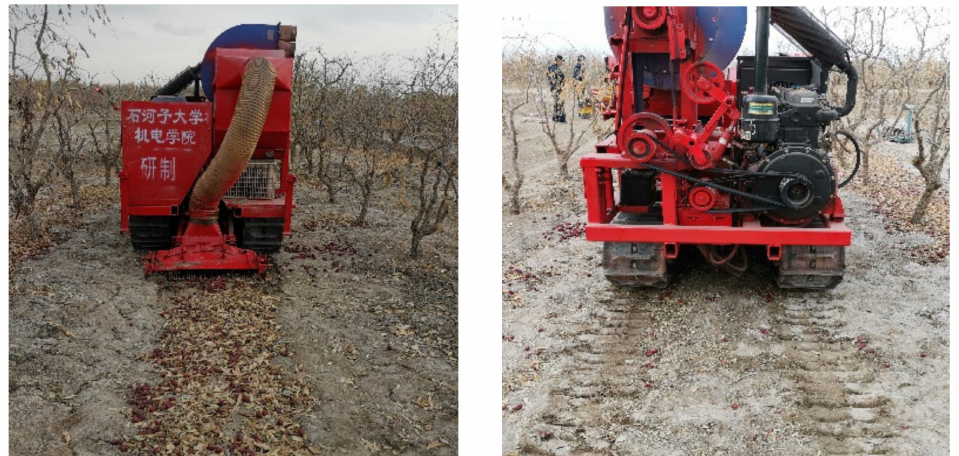
Figure 10. Field verification test process and work performance of the provoke-suction type har- vester for ground jujube fruit (PSH). The Chinese in left image means “developed by the College of Mechanical and Electrical Engineering, Shihezi University”.